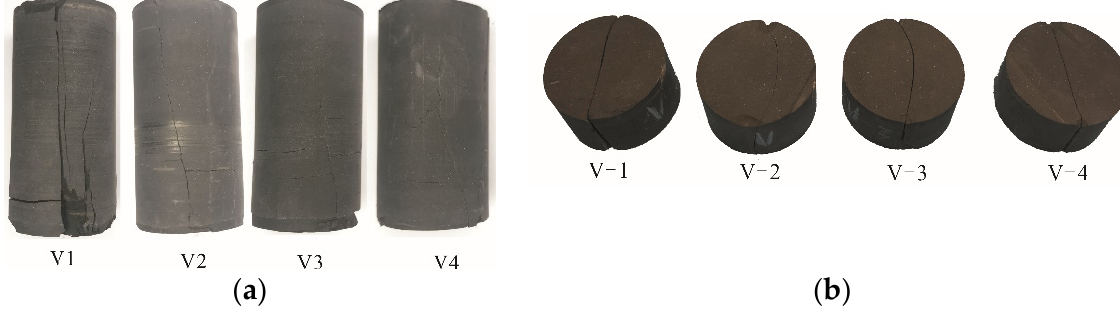
Figure 1. Samples for rock mechanical test: ( a ) after compressive strength test, vertical fractures and bedding planes intersect with each other, forming a complex fracture network; ( b ) after tensile strength test, the fracture perpendicular to bedding planes are relatively straight. Table 1. Experimental results of rock mechanics for Longmaxi shale in changing area. Specimen